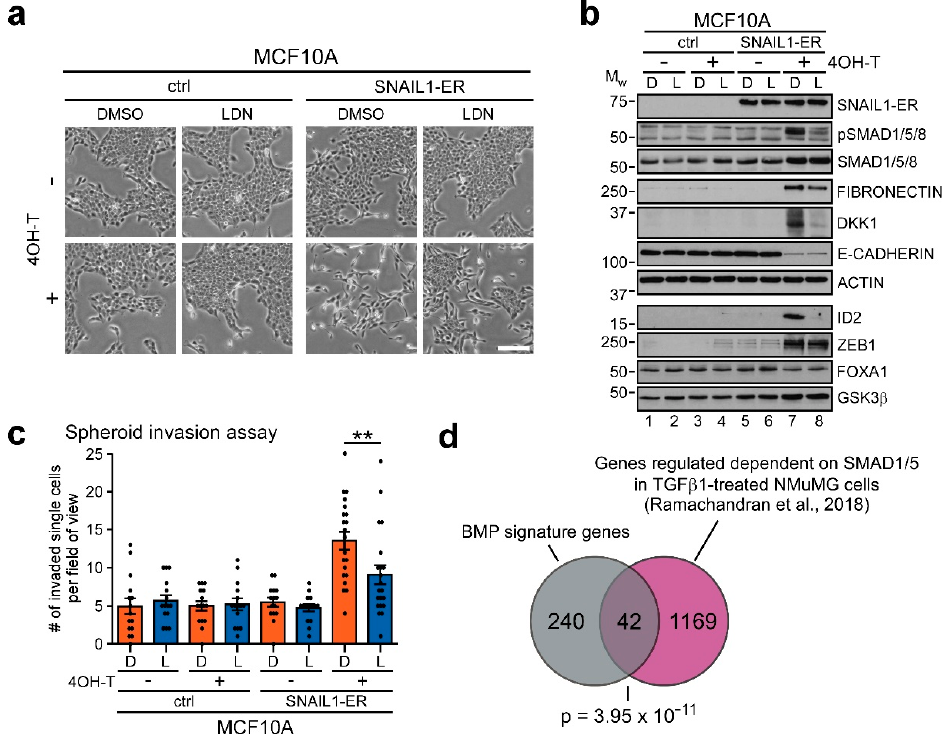
Figure 6. BMP signature genes are also deregulated BMP-dependently in mammary epithelial cells. ( a ) Representative phase contrast images of MCF10A-ctrl or MCF10A-SNAIL1-ER cells treated with ethanol ( − ) or 100 nM 4-hydroxytamoxifen (4OH-T) and DMSO, or 50 nM LDN193189 (LDN) for 10 days as indicated. Scale bar: 200 µ m. ( b ) Western blot analyses of proteins indicated on the right. Cells were treated with ethanol ( − ) or 100 nM 4-hydroxytamoxifen (4OH-T) and DMSO (D), or 50 nM LDN193189 (L) for 10 days as indicated. Positions of molecular weight (M W ) standards in kDa are given on the left. Detection of ACTIN and GSK3 β was used as control for equal loading. Proteins were detected using whole-cell lysates, except for FOXA1, ID2, ZEB1 and GSK3 β for which nuclear extracts were used. As not all proteins could be analyzed on the same membrane, only one representative loading control is shown for the different extraction methods for reasons of simplicity. All corresponding loading controls for the images depicted can be found in Figure S9. ( c ) Quantification of spheroid invasion assays with MCF10A-ctrl and MCF10A-SNAIL1-ER cells. Cells were treated with ethanol ( − ) or 100 nM 4-hydroxytamoxifen (4OH-T) and DMSO (D), or 50 nM LDN193189 (L) for 14 days as indicated. After that, cells were imaged and invaded single cells were counted in ≥ 15 fields of view per condition, which were obtained from three biological replicates. Representative fields of view with examples of single cell quantification are shown in Figure S8b. Shown is the mean ± SEM as well as all individual data points obtained. Data were tested for normality using Shapiro–Wilk tests ( p = 0.018 for sample 8, indicating non-normal distribution). Significance was therefore determined using two-tailed Mann–Whitney U tests. **: p < 0.01. ( d ) Venn diagram showing the overlap of BMP signature genes with all genes that are regulated by TGF β 1 in NMuMG cells in a SMAD1/5-dependent manner [39]. Shared genes and details of the analysis are listed in Table S4. The significance of enrichment was determined by hypergeometric test; the p -value is